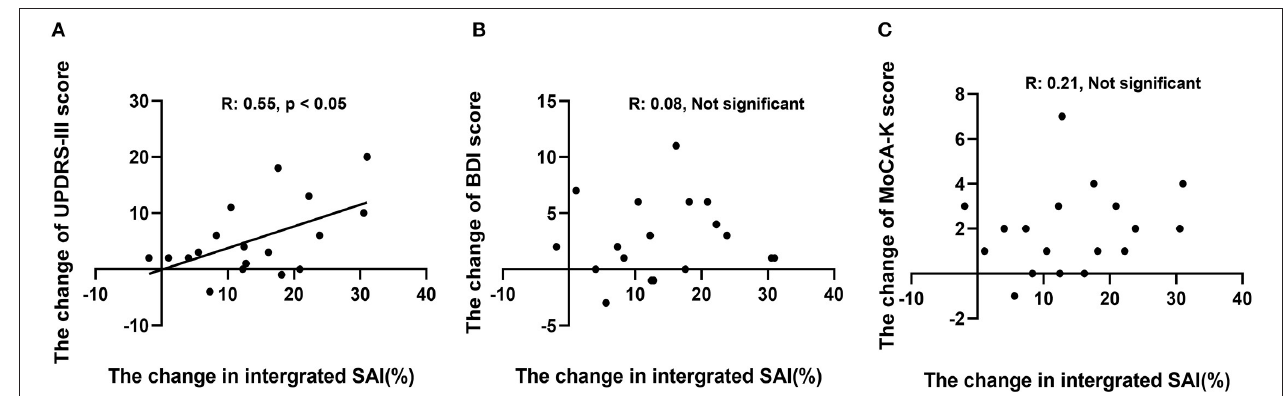
FIGURE 3 | Correlation analysis between change in SAI (%) and change in each outcome variable. (A) Changes in UPDRS-III scores showed a positive, significant correlation ( R : 0.55, p < 0.05). (B,C) Changes in MoCA-K and BDI scores did not reveal a significant correlation with SAI (%) changes.